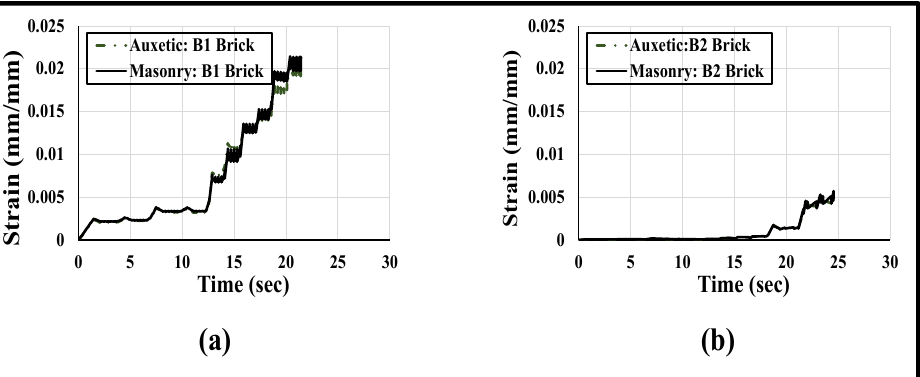
Figure 22. Stress-strain curves of the auxetic-strengthened cyclic loaded wallettes constructed using ( a ) B1 and ( b ) B2 bricks under cyclic compression loading. A simplified illustration of the axial strain distribution with respect to time on the